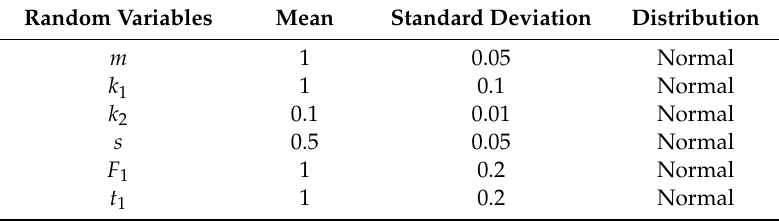
Table 4. Distribution parameters of the random variables of Example